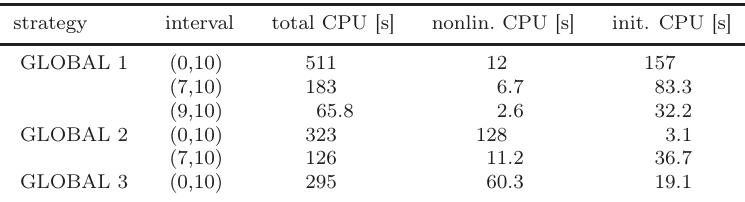
Table 1. CPU times for nonlinear Arnoldi with global restarts.